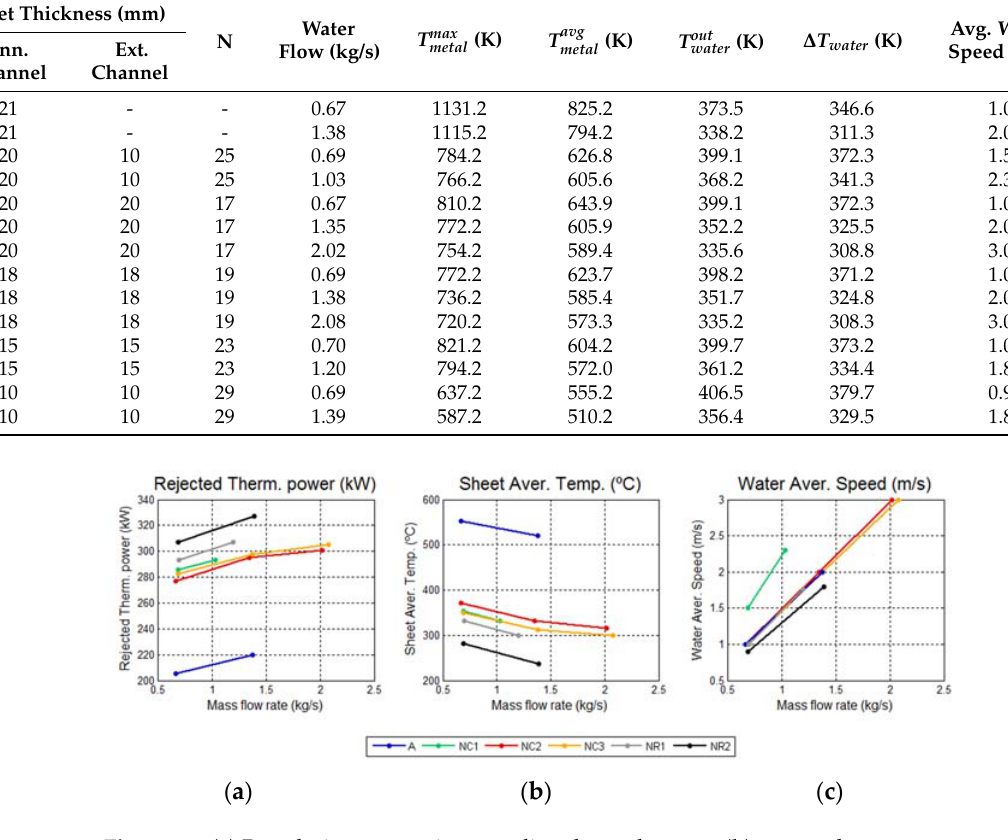
Figure 11. ( a ) Port design comparison: cooling thermal power; ( b ) upper plate average temperature; ( c ) cooling water average speed. Table 1. Port design comparison.